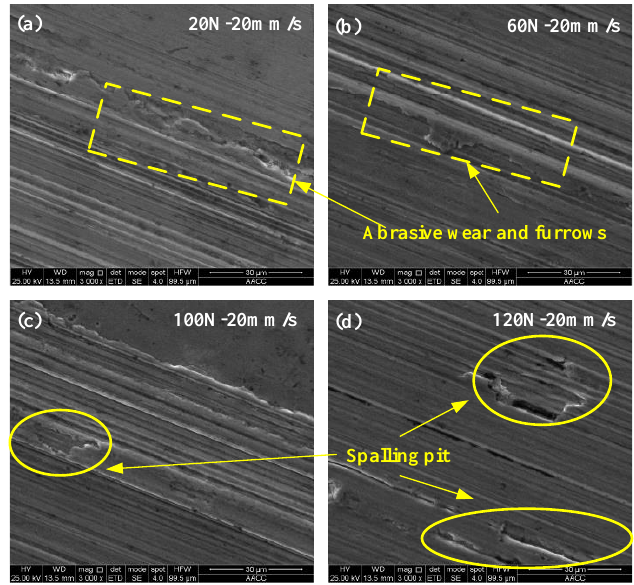
Figure 10. SEM of wear scars of sample oil #2 under different loads at the same sliding speed. ( a ) 20 N-20 mm/s; ( b ) 60 N-20 mm/s; ( c ) 100 N-20 mm/s; ( d ) 120 N-20 mm/s. 20 N-20 mm / s; ( b ) 60 N-20 mm / s; ( c ) 100 N-20 mm / s; ( d ) 120 N-20 mm /